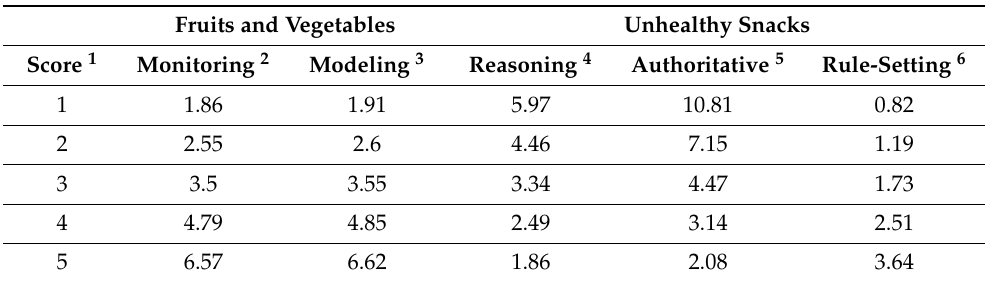
Table 9. Race/ethnicity and parenting practices/styles and the average number of fruits and vegeta- bles and consumption of unhealthy snacks.